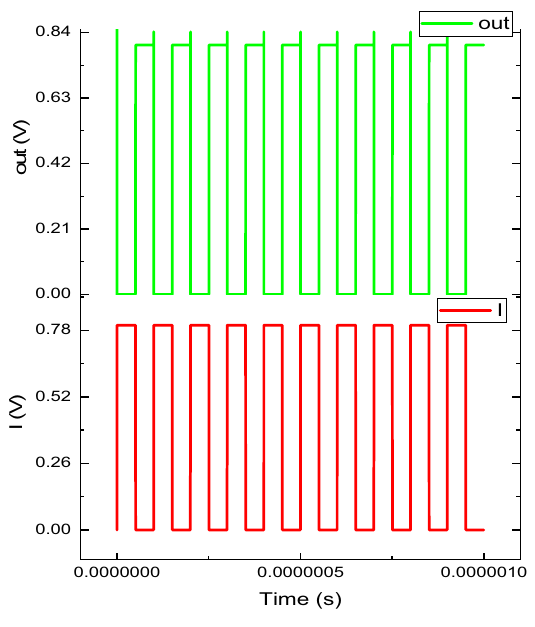
Figure 4. ( a ) Inverter logic circuit realization using poc-DG-AJLTFET. ( b ) Timing diagram of inverter logic circuit using